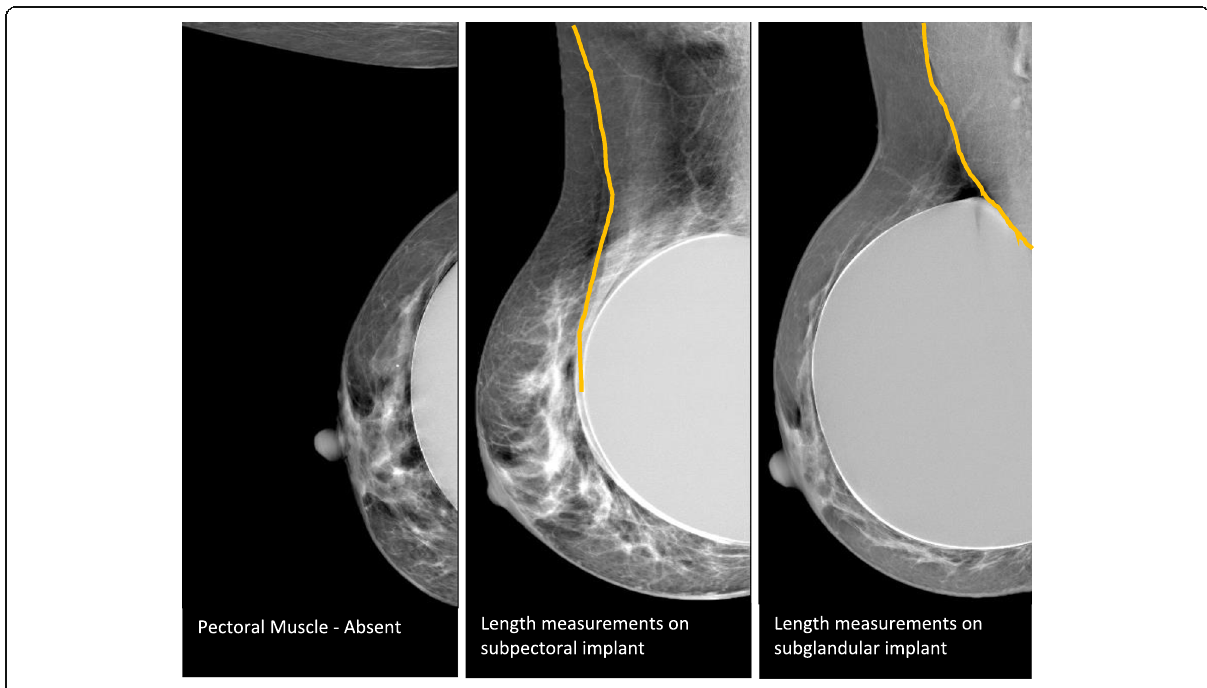
Fig. 1 Strategy to measure the length of pectoral